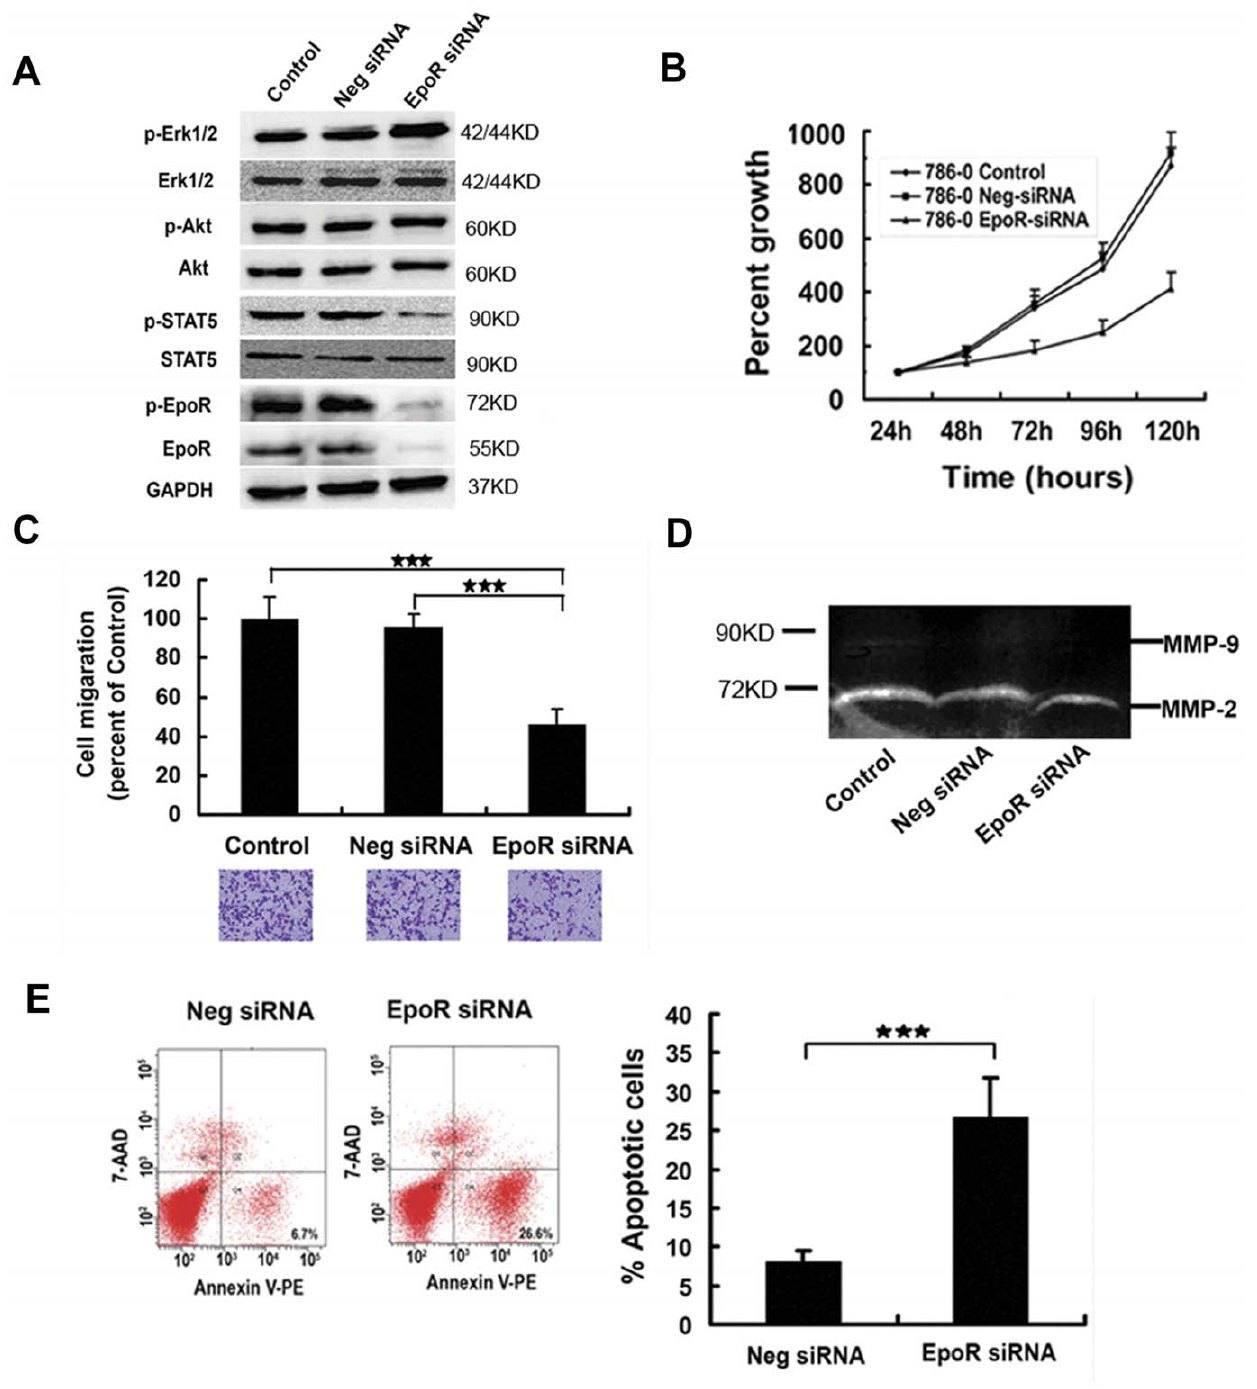
Figure 3. Change of signaling molecules, proliferation, apoptosis, invasion ability and MMP-2 expression in 786-0 cells with knockdown EpoR. (A) Signaling molecules were assayed in 786-0 expressing EpoR siRNA (EpoR siRNA) by western blot, using parental 786-0 cells (control) and 786-0 expressing negative siRNA (Neg siRNA) as controls. In 786-0 cells expressing EpoR siRNA, EpoR and p-EpoR decreased by . 90%, p-STAT5 decreased by . 60%, but p-Erk1/2 increased by . 36%, as compared with those in the two controls. (B) Proliferation rate reduced significantly in 786-0 expressing EpoR siRNA by modified MTT method (experiments in triplicate; P , 0.01), as compared with that at the same time point in the two controls. (C) Invasion ability decreased by about 55% in 786-0 expressing EpoR siRNA by transwell test (tests in triplicate; www : P , 0.001). (D) MMP-2 expression was inhibited by 33% in 786-0 expressing EpoR siRNA by gelatin zymography, and MMP-9 expression was very low in the 3 groups of 786-0 cells. (E) Early apoptotic cells (annexin V-PE + /7-AAD - ) increased by about 4 times in 786-0 expressing EpoR siRNA, as compared to those of 786-0 expressing negative siRNA by flow cytometry (experiments in triplicate; www : P , 0.001).